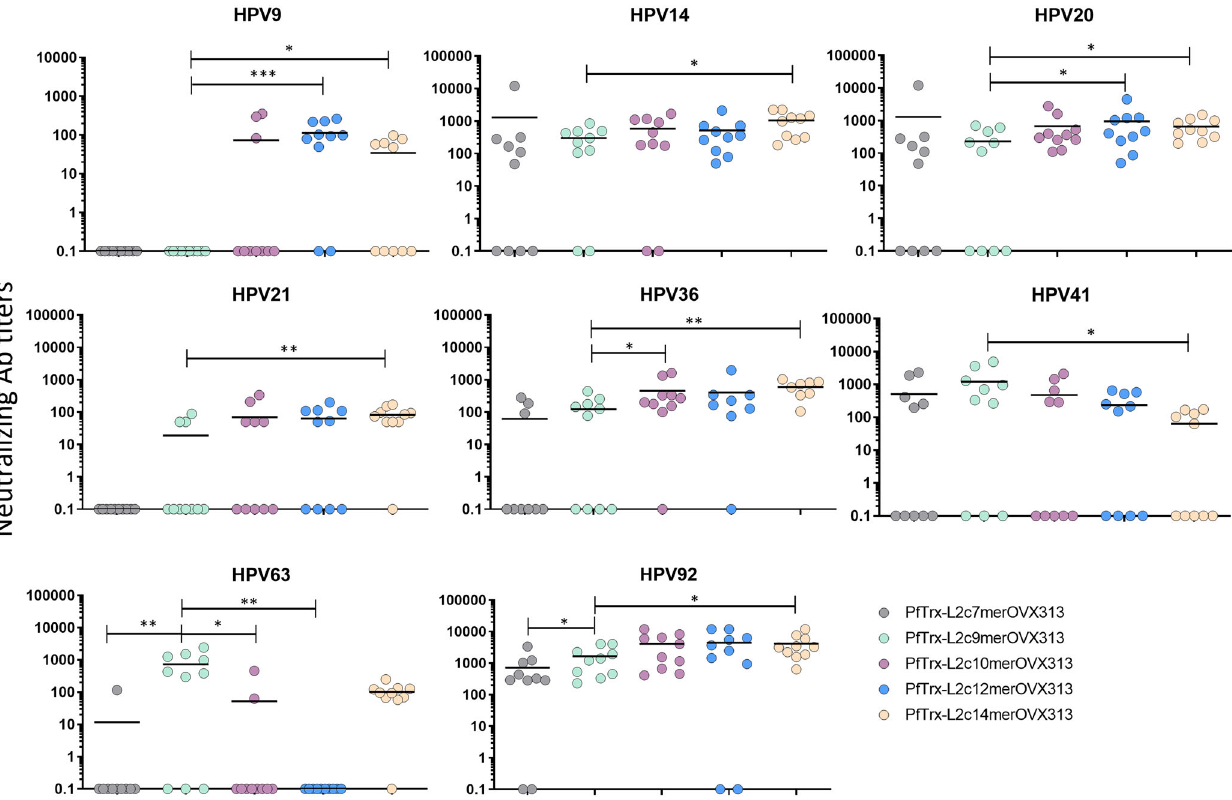
Fig. 6 The PfTrx-L2c12merOVX313 and PfTrx-L2c14merOVX313 candidate vaccines induce enhanced immune responses to cutaneous HPV types compared to PfTrx-L2c9merOVX313. Neutralizing antibody titers to eight HPV types measured by the L1-PBNA in sera from mice immunized with 20 µg of the indicated Trx-L2 antigens. Each dot represents the EC50 value measured in one animal serum; horizontal lines (per column) correspond to the mean antibody titers. A P -value of ≤ 0.05 was considered signi fi cant. * P < 0.05; ** P < 0.01; *** P < 0.001, as determined by the nonparametric Mann – Whitney test. EC50 values <50 were considered non-neutralizing and therefore set to